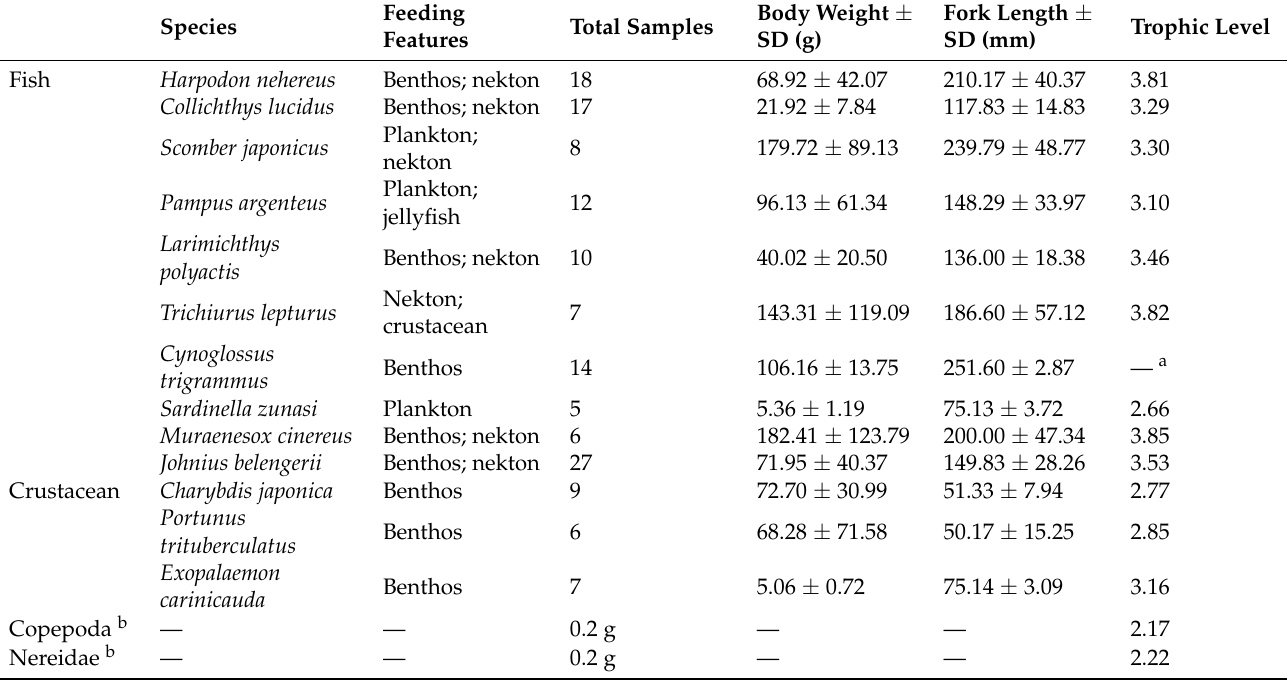
Figure 1. Sampling locations at the Zhoushan fishing ground between July and October 2019. Table 1. Basic biological data and trophic levels of captured marine organisms in the Zhoushan fishing ground.